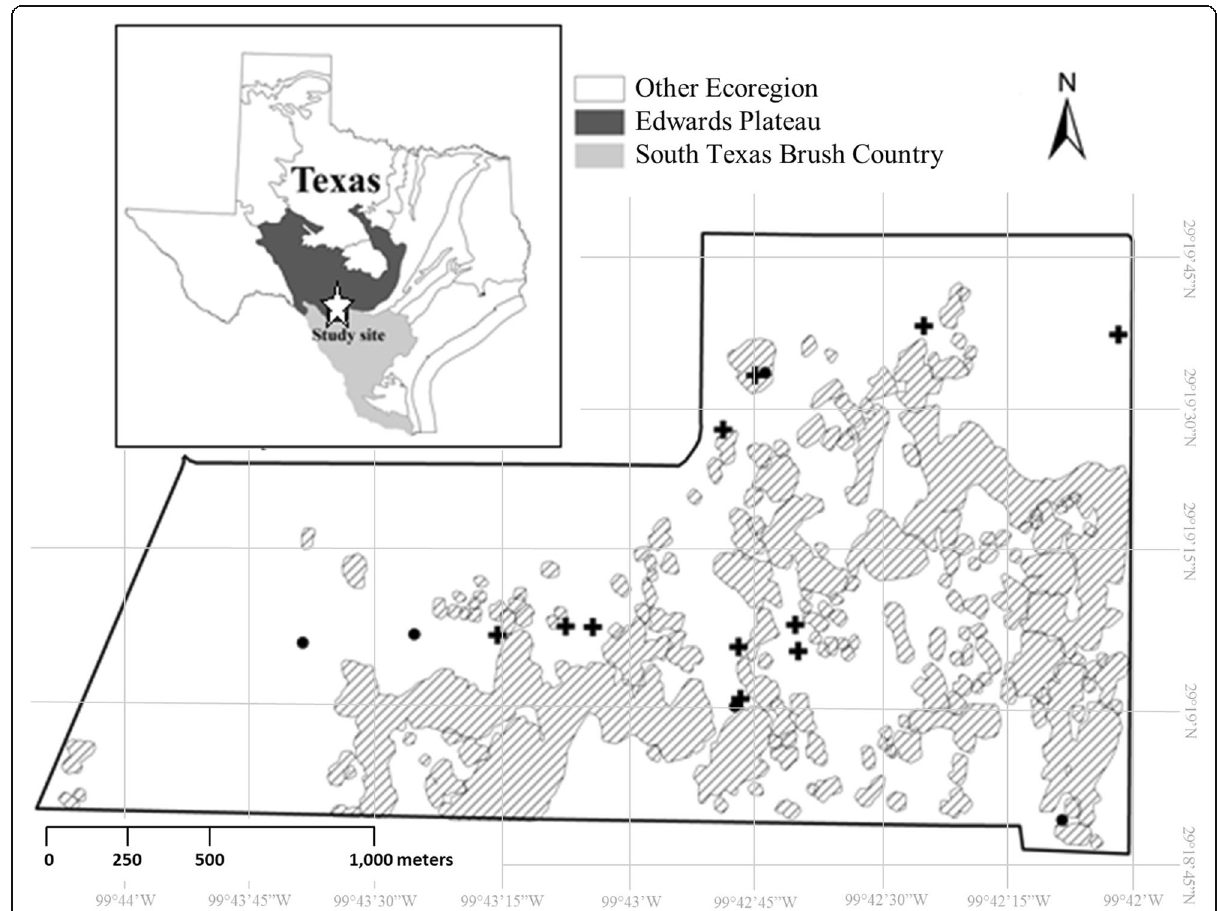
Fig. 1 The 457-ha study site is a gentle terrain semi-arid rangeland located between two ecological regions: Edwards Plateau and South Texas Brush Country, TX, USA. Water locations (black circles), supplemental feeding areas (black crosses), and shade patches (areas with diagonal lines) were delineated within the study